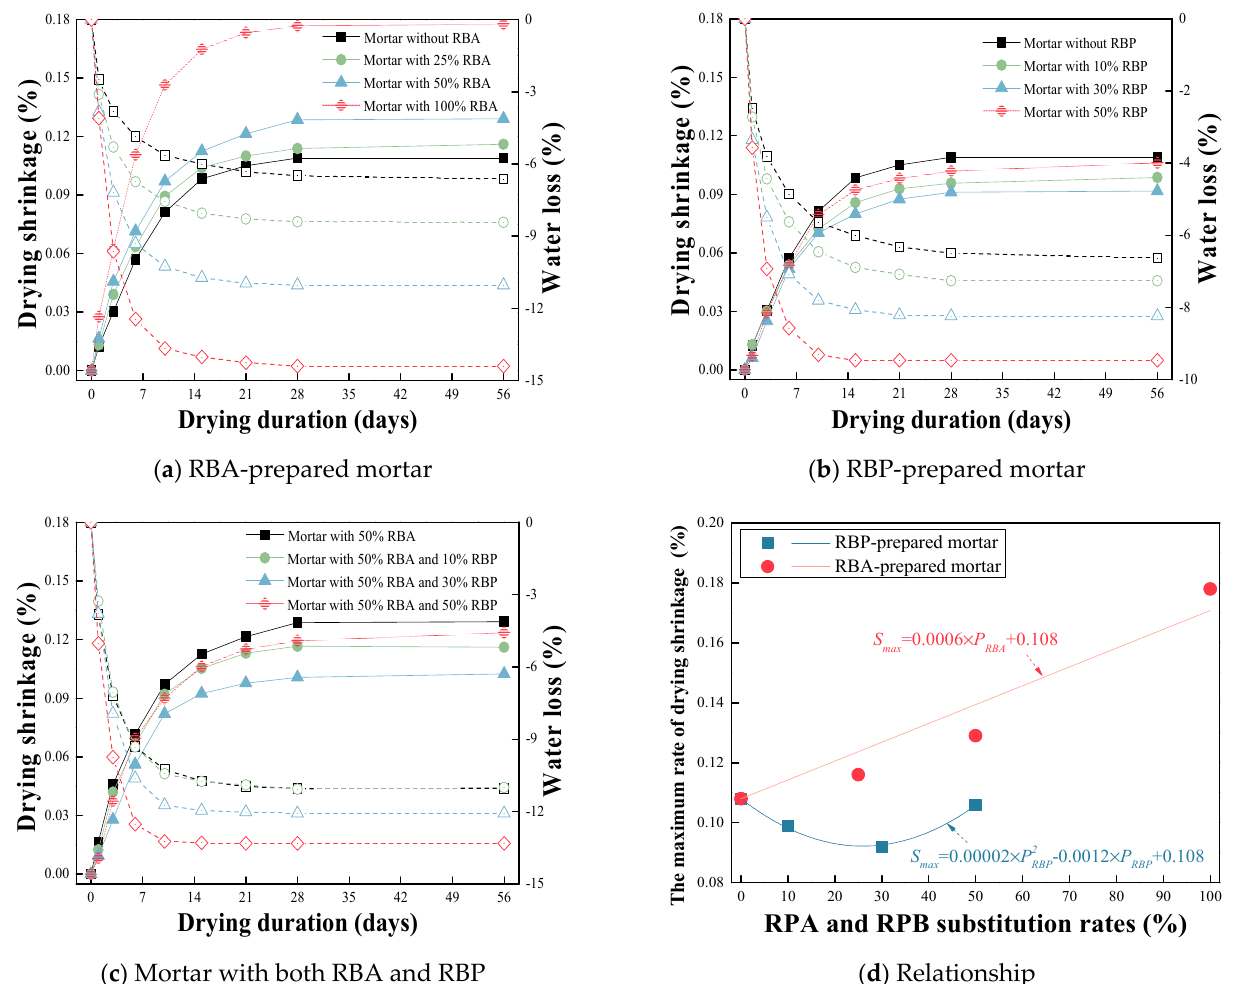
Figure 9. Drying shrinkage of cementitious materials with RBA and RBP.